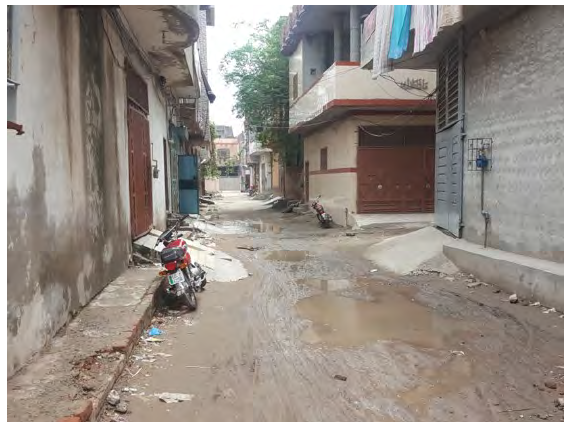
Figure 4. Alley view in Qalandar Pura, Source: